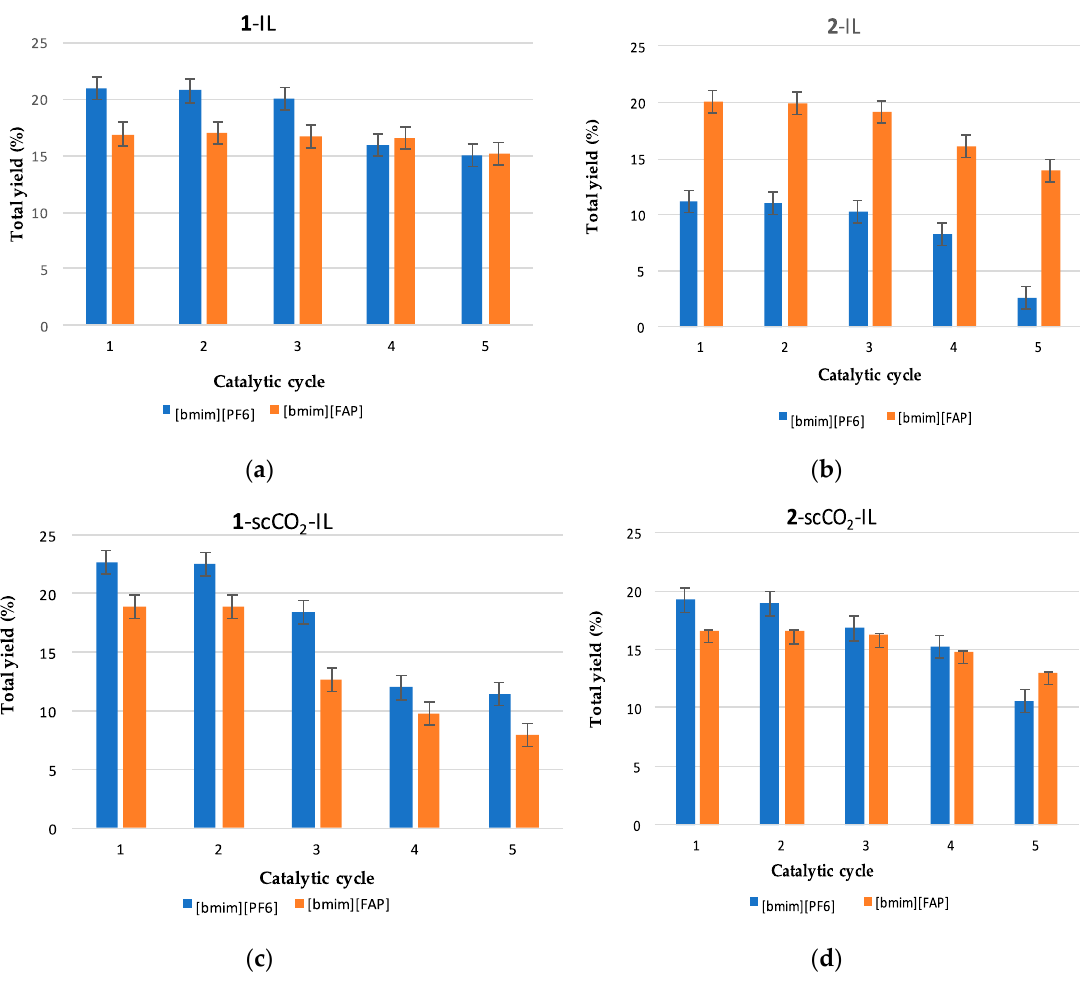
Figure 3. Products yield upon catalyst recycling in ( a ) ionic liquid (IL) for catalyst 1 (reaction time: 6 h), ( b ) IL for catalyst 2 (reaction time: 6 h), ( c ) scCO 2 ‐ IL for catalyst 1 ( p (CO 2 ) = 90 bar and 6 h of reaction time) and ( d ) scCO 2 ‐ IL for catalyst 2 ( p (CO 2 ) = 90 bar and 6 h of reaction time).